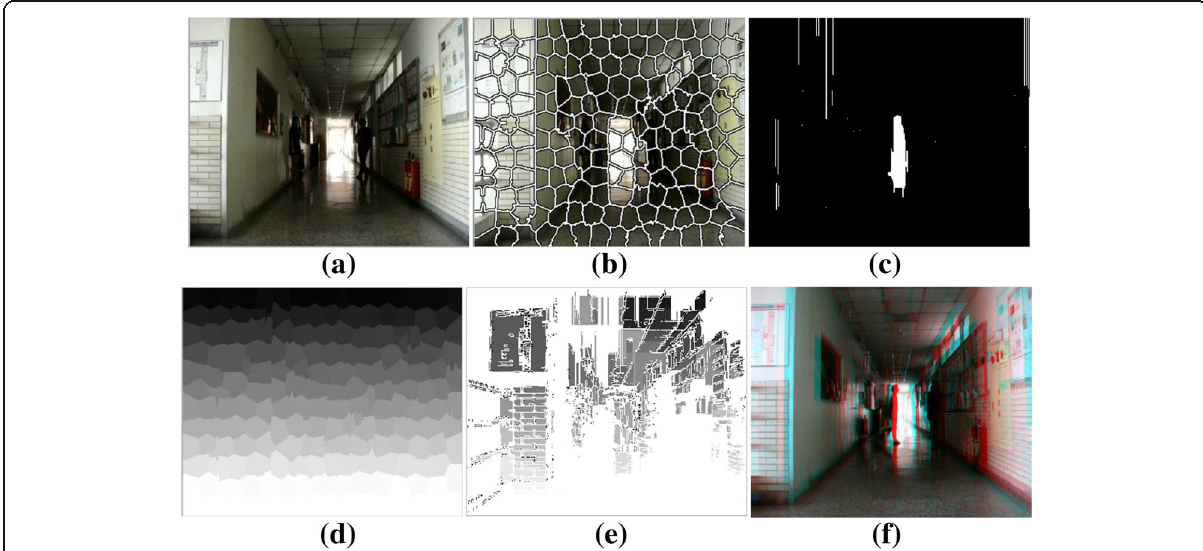
Fig. 10 Experimental results. a Original image. b Results of simple linear iterative clustering. c Results of foreground detection. d Initial depth map. e Final depth map. f Anaglyph